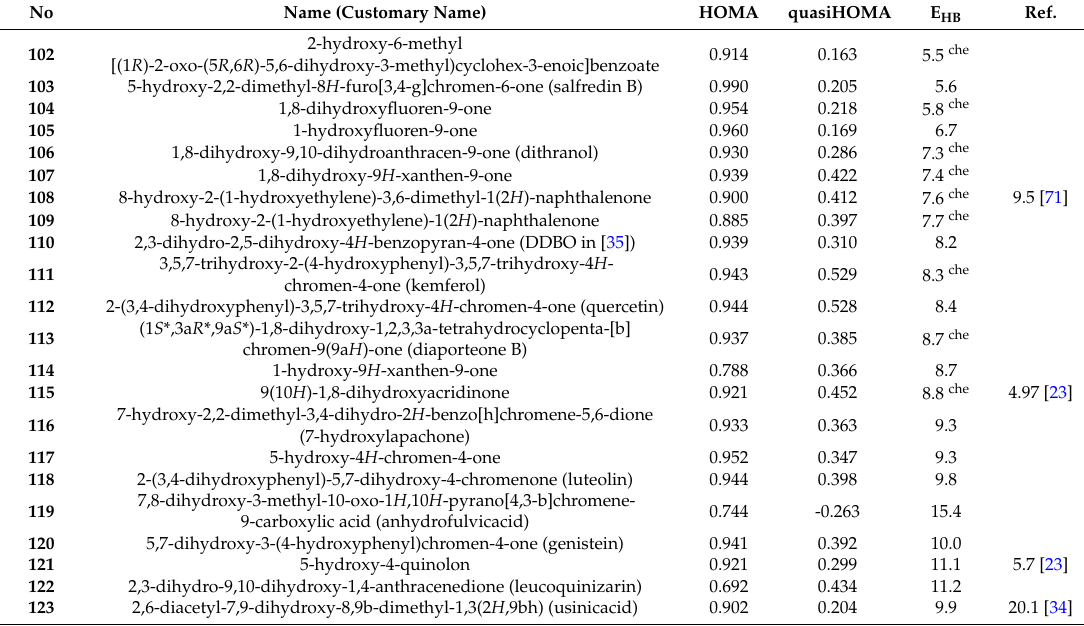
Table 4. Energy of hydrogen bond (kcal/mol) as well as HOMA and quasiHOMA indices calculated for HB rings for some biological active phenols.